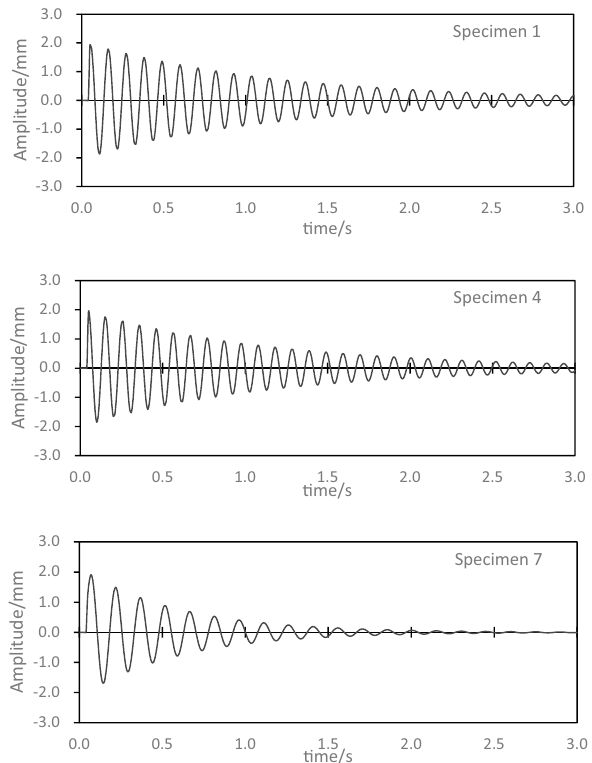
Figure 5. Damping experiment of samples with different laying angles.